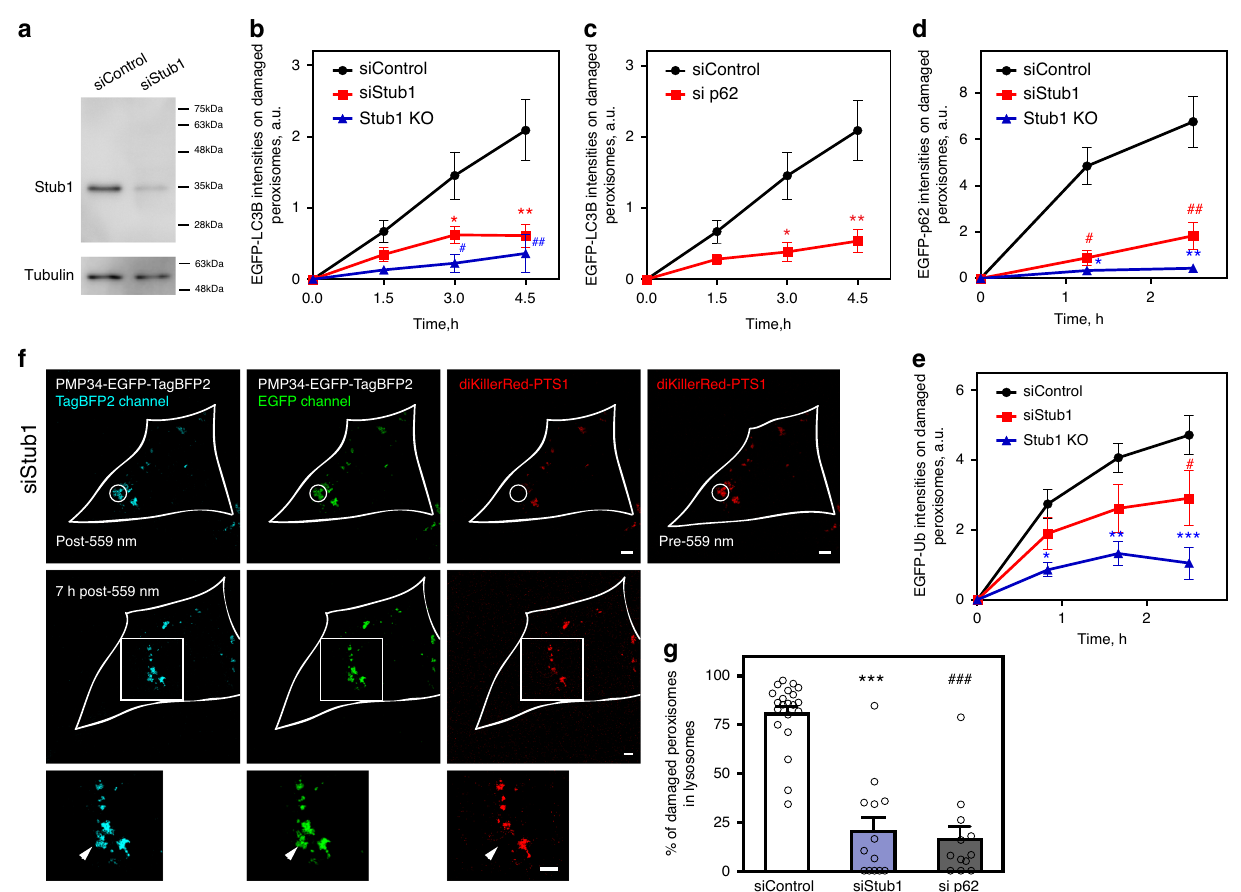
Fig. 4 Stub1 depletion blocks pexophagy. a Stub1 depletion ef fi ciency (siRNA) in our experiments. b Depleting Stub1 in NIH3T3 cells reduced EGFP-LC3B accumulation on ROS-stressed peroxisomes (quanti fi ed LC3B accumulation on ROS-stressed peroxisomes using the experimental setup in Fig. 1h – j; siControl, n = 10 cells; siStub1, n = 16 cells; Stub1 KO, n = 8 cells). * P = 0.0051, ** P = 0.0004, # P = 0.0023, and ## P = 0.0019 (one-tailed t test). c Depleting p62 similarly reduced EGFP-LC3B accumulation on ROS-stressed peroxisomes (siControl, n = 10 cells; si p62, n = 10 cells). * P = 0.0039 and ** P = 0.0007 (one-tailed t test). d Depleting Stub1 in NIH3T3 cells reduced EGFP-p62 accumulation on ROS-stressed peroxisomes (siControl, n = 6 cells; siStub1, n = 12 cells, Stub1 KO, n = 11 cells). * P = 8.77E − 07, ** P = 4.90E − 07, # P = 2.33E − 05, and ## P = 0.0002 (one-tailed t test). e Depleting Stub1 in NIH3T3 cells reduced EGFP-Ub accumulation on the ROS-stressed peroxisomes (siControl, n = 10 cells; siStub1, n = 11 cells, and Stub1 KO, n = 10 cells). * P = 0.0004 ** P = 3.29E − 05, *** P = 3.51E-05, and # P = 0.0393 (one-tailed t test). All error bars in b – e represent mean ± SEM. f The peroxisomes within the white circular region in a NIH3T3 cells expressing PMP34-EGFP-TagBFP2 and diKillerRed-PTS1 were illuminated with 559 nm (top panels). Depletion of Stub1 reduced the rate of EGFP signals loss from ROS-stressed peroxisomes (middle panels: 7 h after 559 nm illumination; bottom panels: magni fi ed view of the white square region in the middle panels). g The percentage of peroxisomes that entered lysosomes (TagBFP2 + EGFP − ) 7 h following 559 nm illumination (siControl, n = 21 cells; siStub1, n = 13 cells, and si p62, n = 12 cells, *** P = 9.63E − 10, ### P = 9.04E − 11, one-tailed t test). All error bars represent mean + SEM. All scale bars: 5 μ m. Source data are provided as a Source data fi